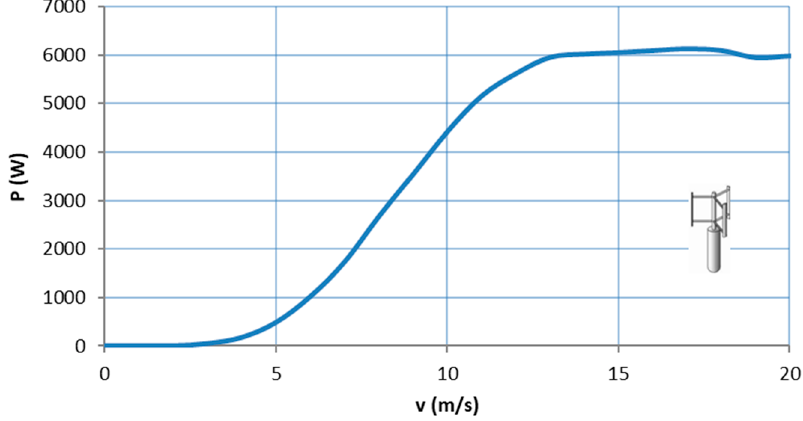
Figure 15. Power curve for the standard air density ρ std = 1.225 kg/cm 2 . Source [86].